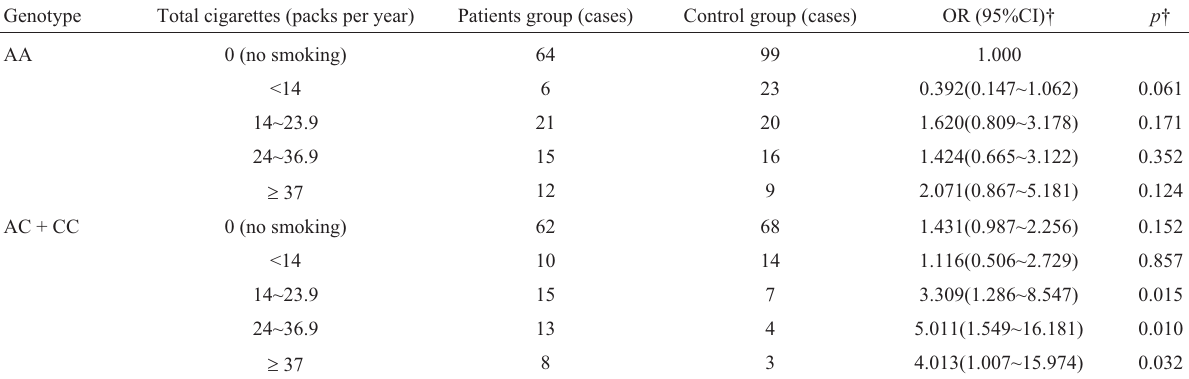
Table 8 - Relationship between total cigarettes per year with rs13181-locus polymorphic genotypes and susceptibility of pancreatic cancer.